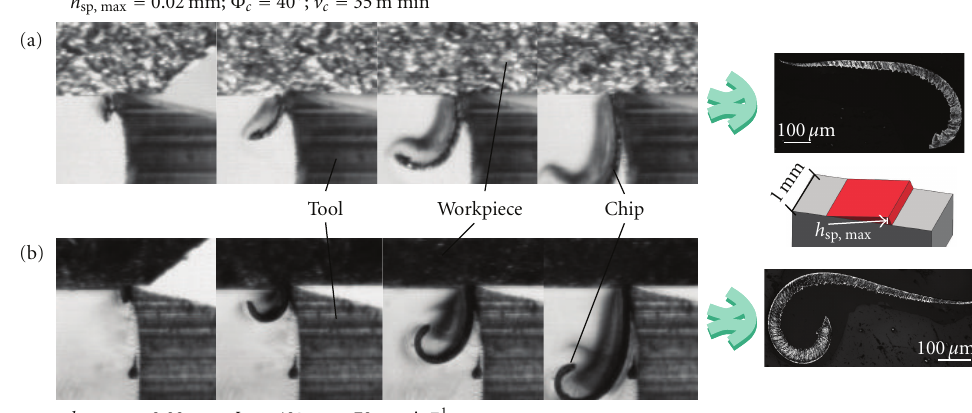
Figure 10: Investigation of chip curve and serration; (a) low and (b) high chip curve and